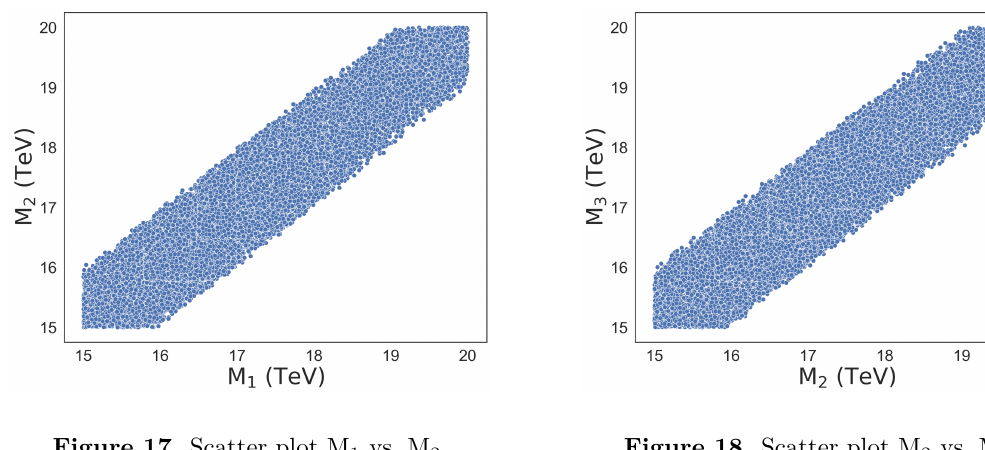
Figure 17 . Scatter plot M 1 vs. M 2 . Figure 18 . Scatter plot M 2 vs. M 3